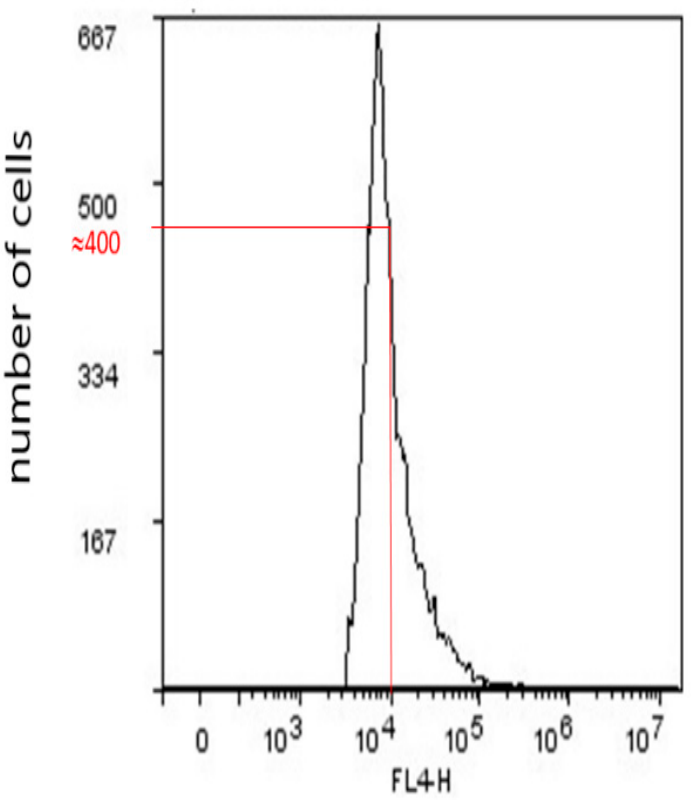
Figure 6. Strategy of GMI calculation. Notes: Approximately 400 cells have a fluorescence intensity of 10,000.